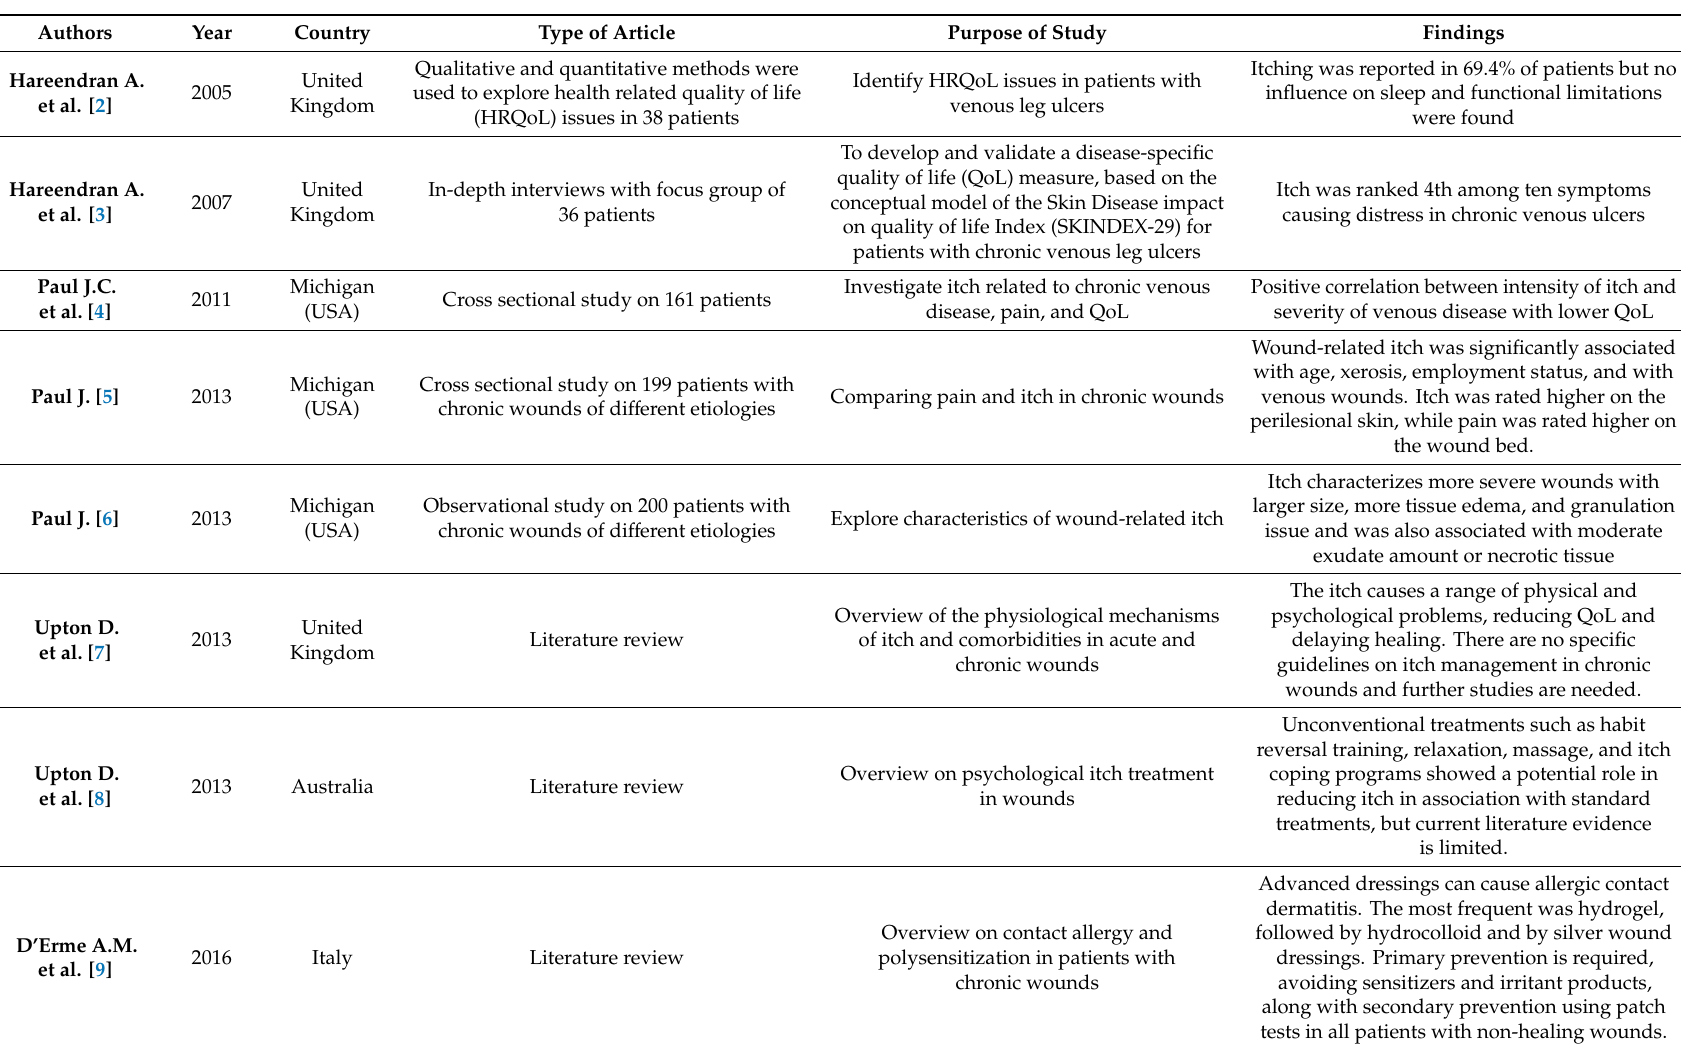
Table 1. Key data from literature